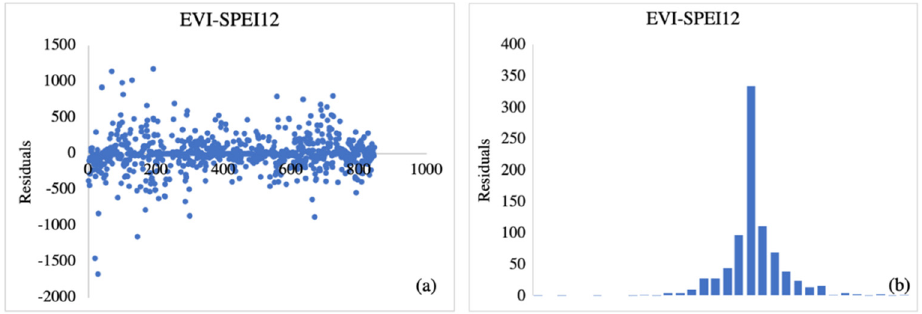
Figure 3. Plot of ANN crop yield prediction randomness residuals (a) and normal distribution histogram (b).